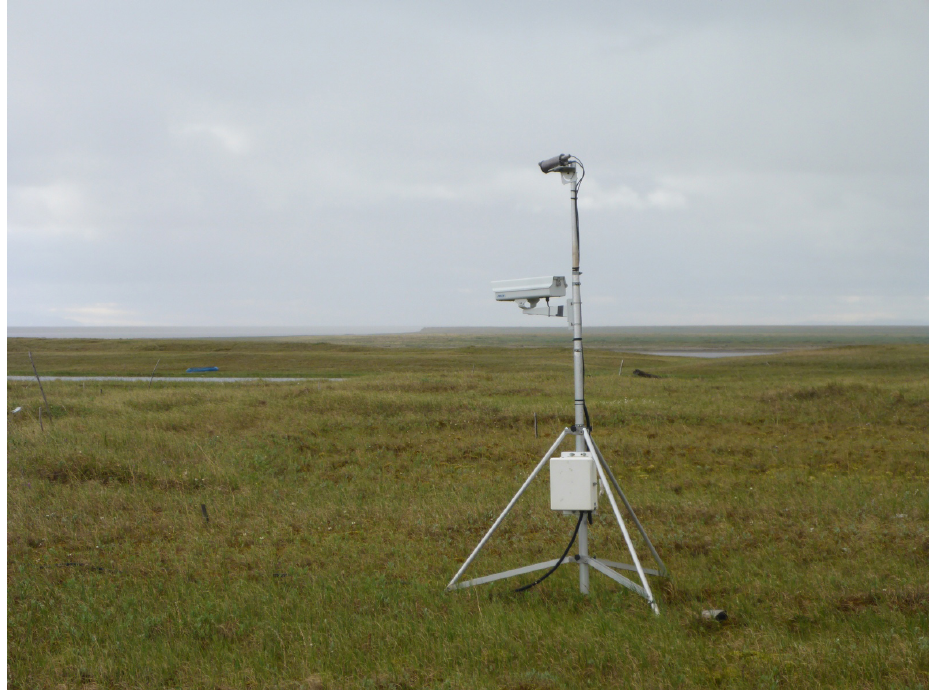
Figure B5. Cameras for time-lapse photography of snow cover and land surface pointing towards the polygon field: a Campbell Scientific CC5MPX at the top (since 4 August 2015) and a Campbell Scientific CC640 below (since 1 September 2006). Photo taken in 2016.